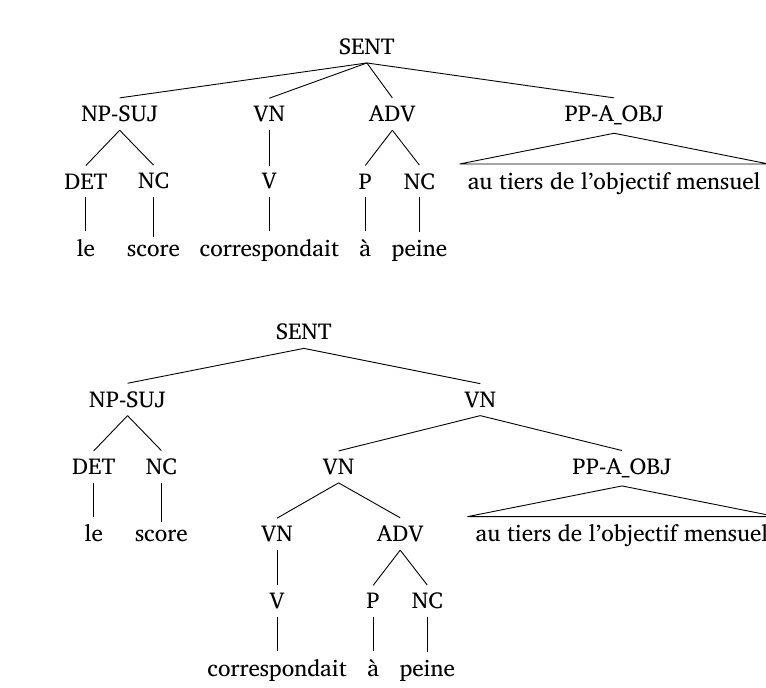
Figure 2: Initial French Treebank tree.